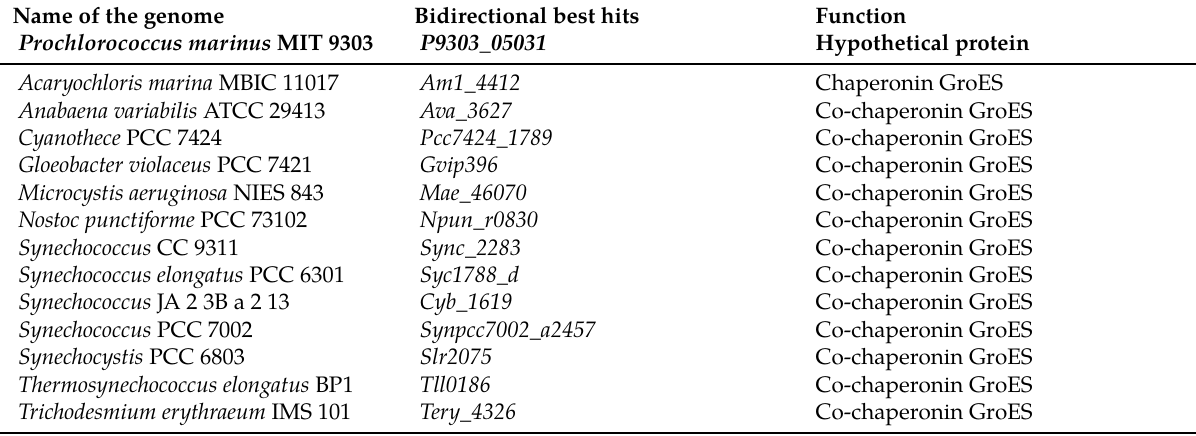
Table 1: Table representing names of the genomes, their bidirectional best hit and its function among different cyanobac- terial